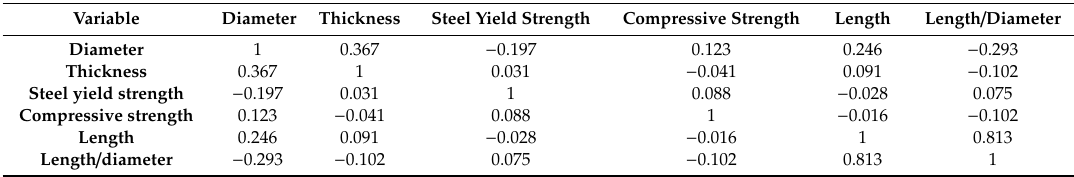
Table 2. Correlation coe ffi cients for di ff erent